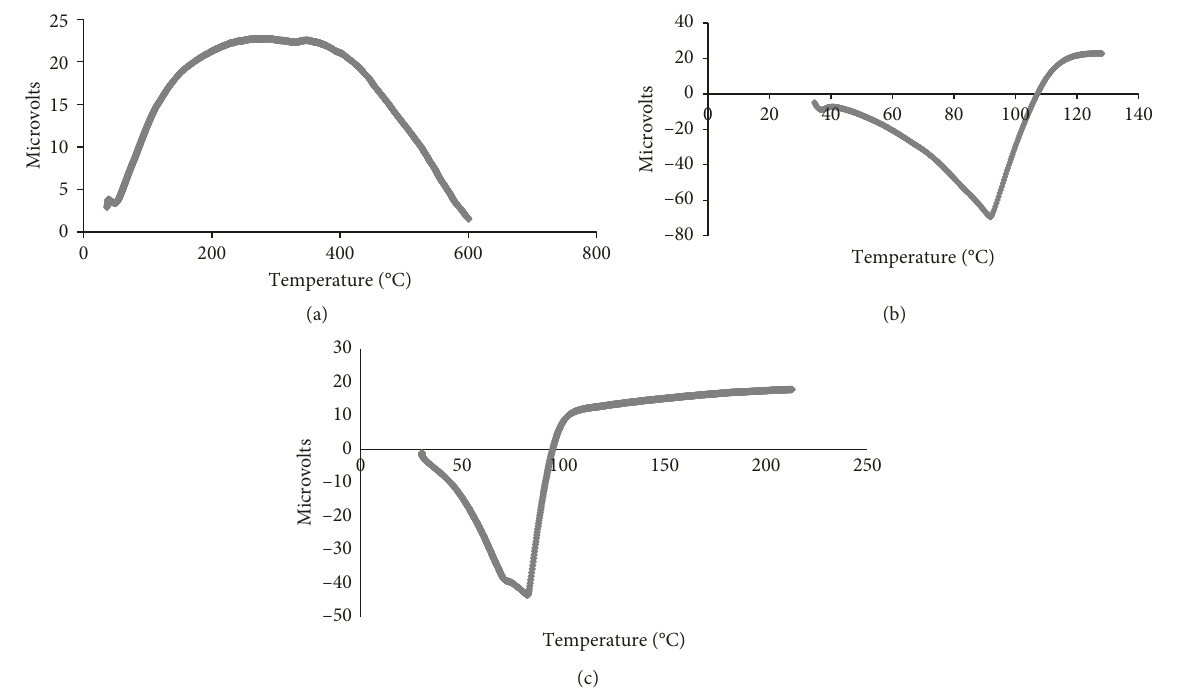
Figure 11: DTA curve for (a) untreated PR leaves, (b) brilliant green-treated PR leaves, and (c) acid orange-treated PR